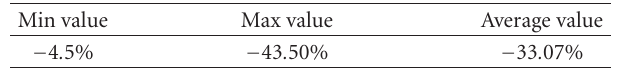
Table 4: Reduction of the HTML document size.